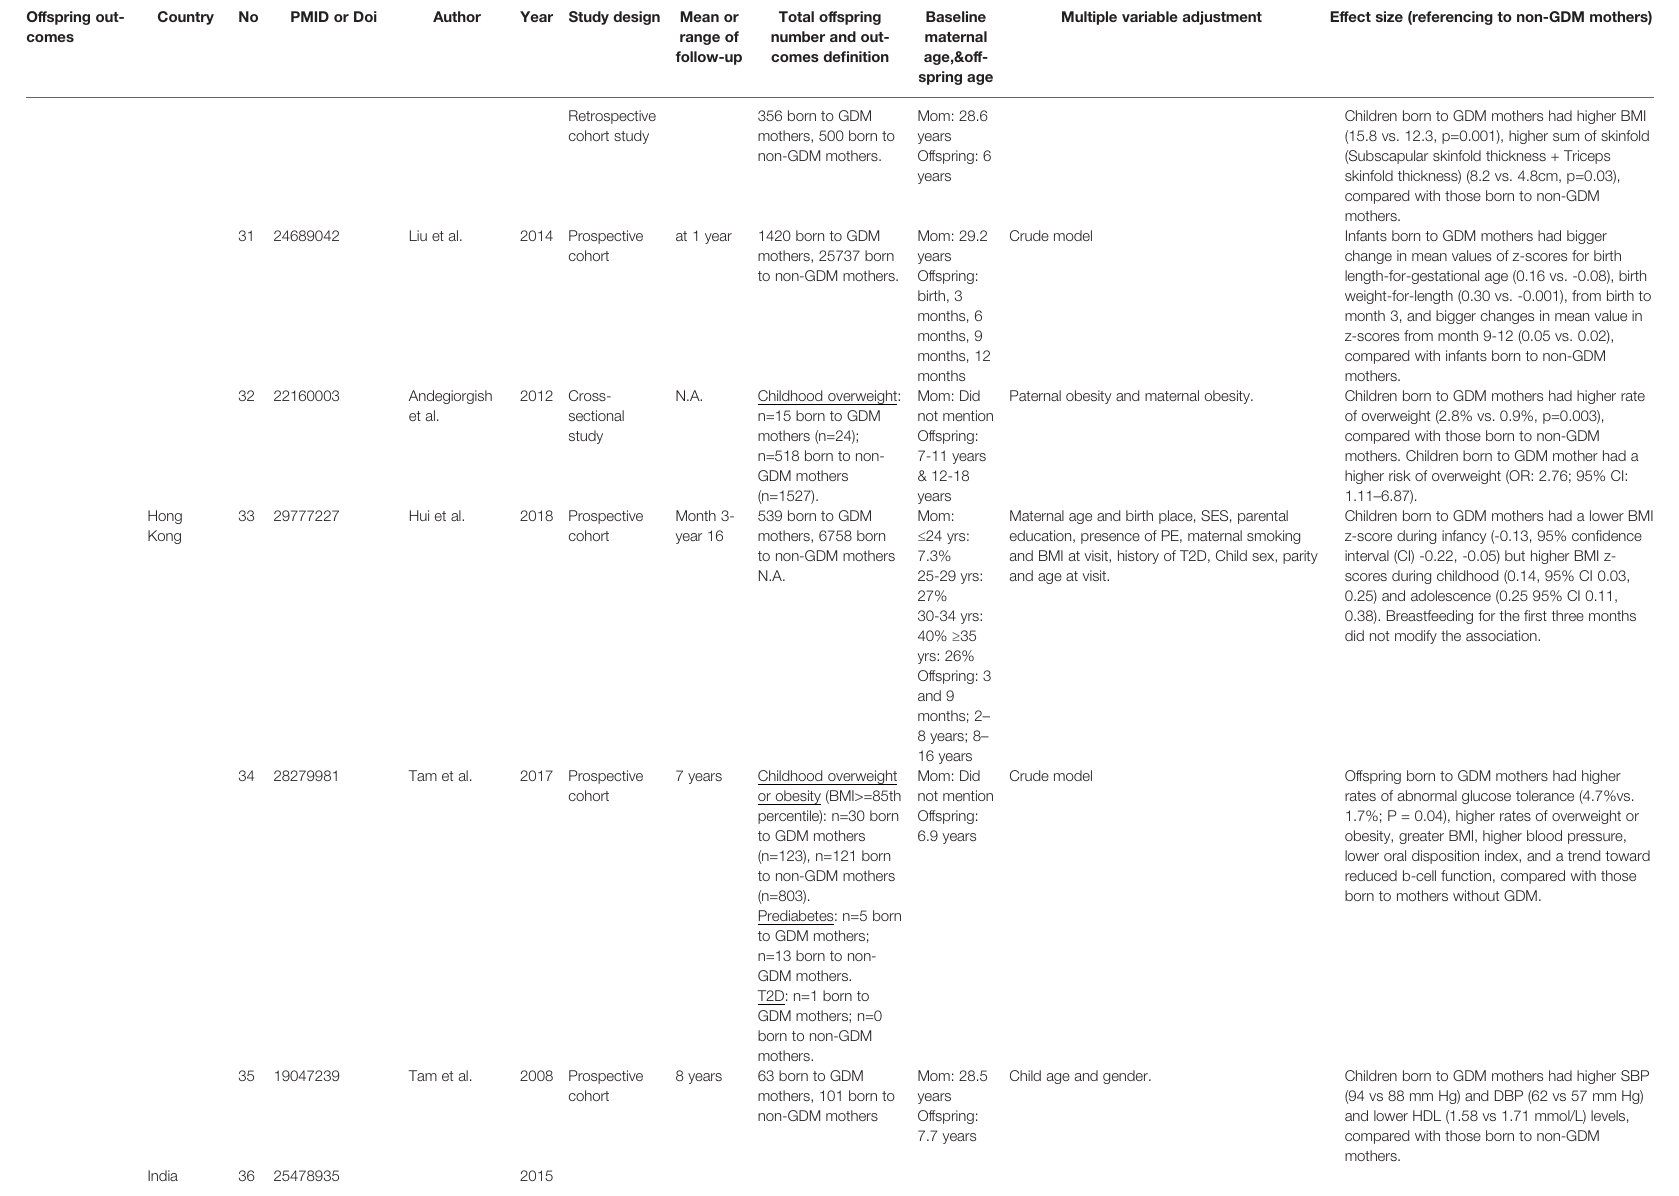
(94 vs 88 mm Hg) and DBP (62 vs 57 mm Hg) and lower HDL (1.58 vs 1.71 mmol/L) levels, compared with those born to non-GDM mothers.